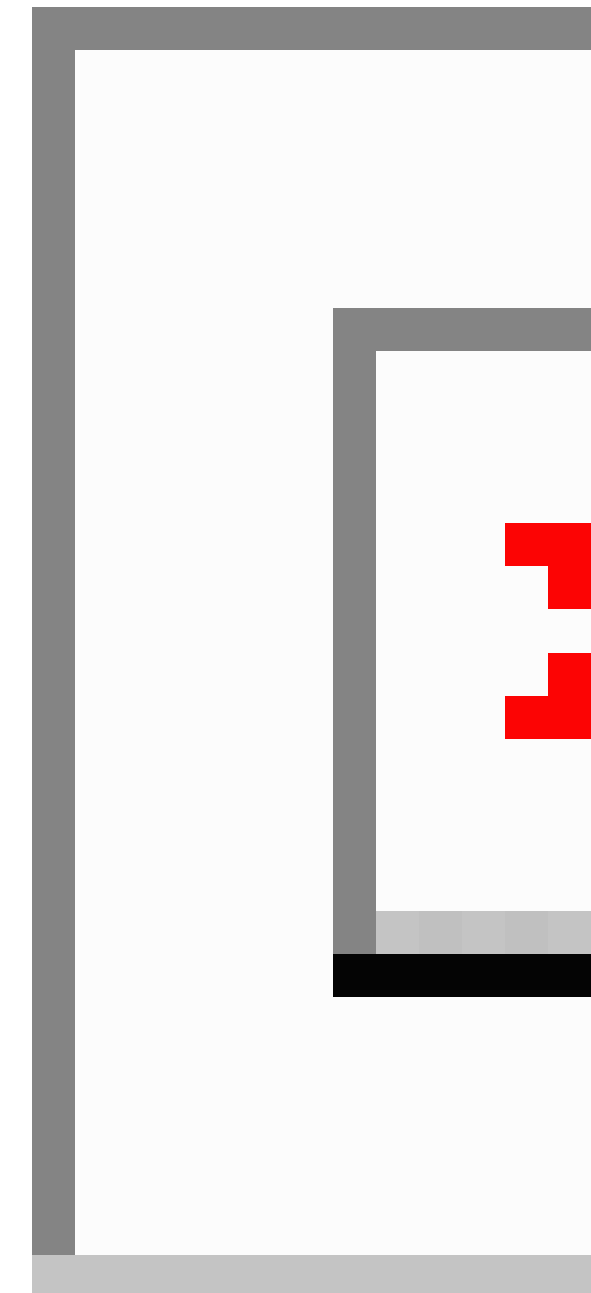
Figure 3. Examples of COGWEB